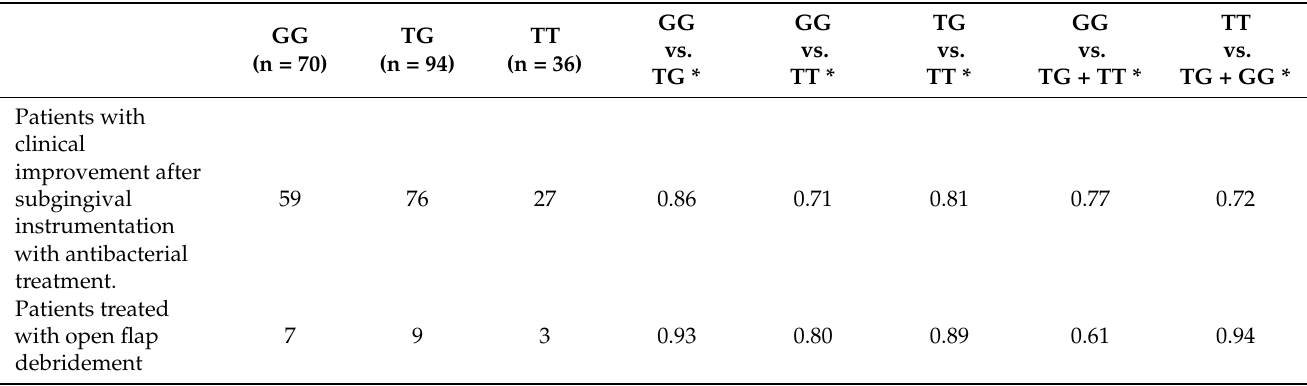
Table 8. The associations between the results of therapy and IL-18 rs1946518